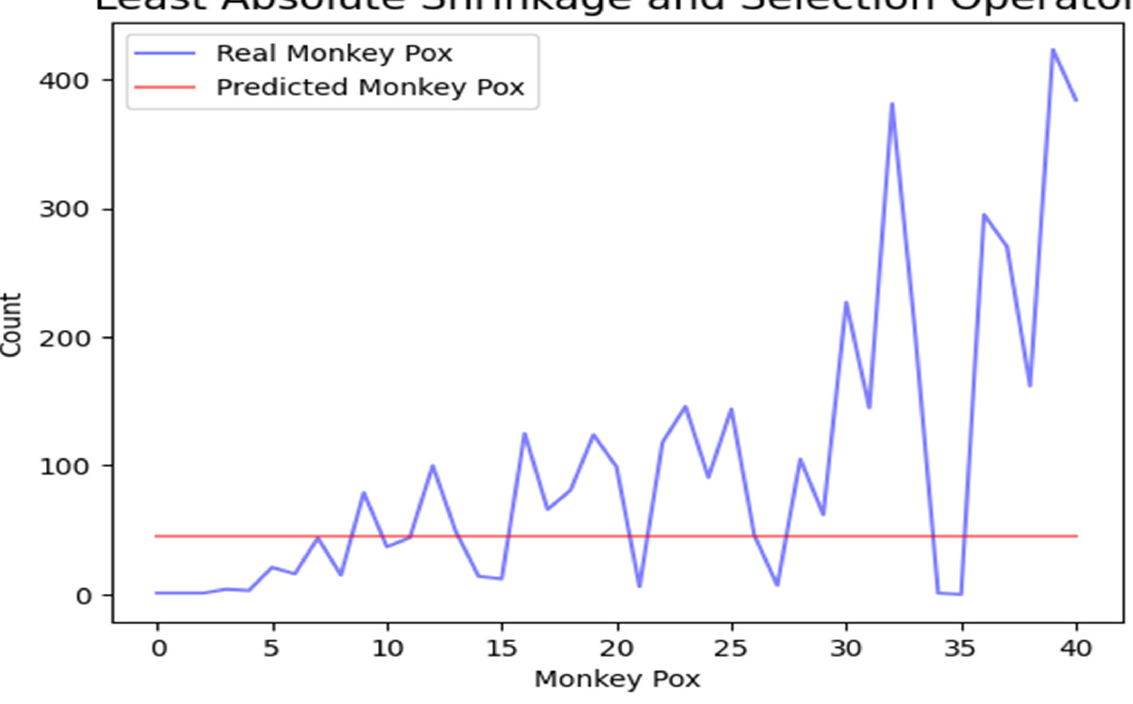
Figure 12. Time Series of Least Absolute Shrinkage and Selection Operator Algorithm.